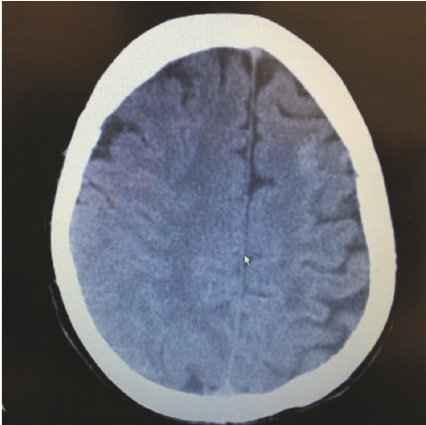
Figure 1: CT head showing left frontal hyperdense lesion on left frontal region.